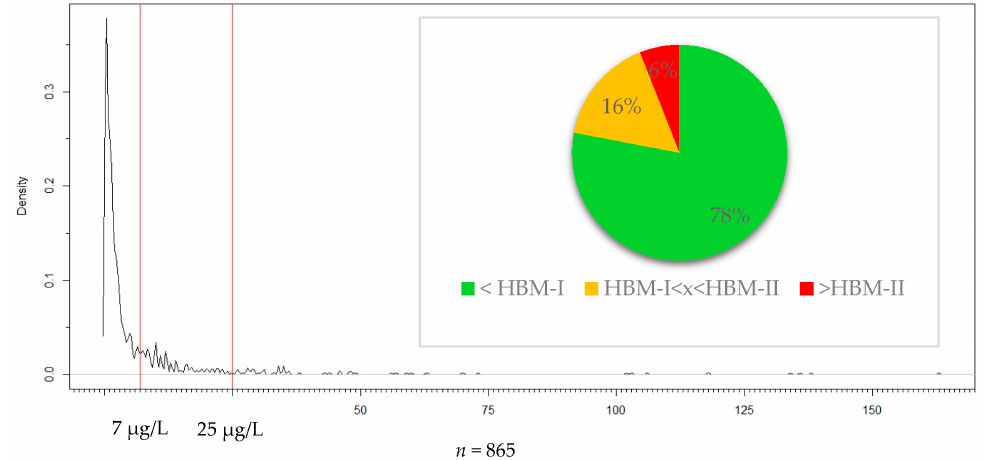
Figure 2. Estimated density distribution of the Ecuadorian mining population together with the HBM-